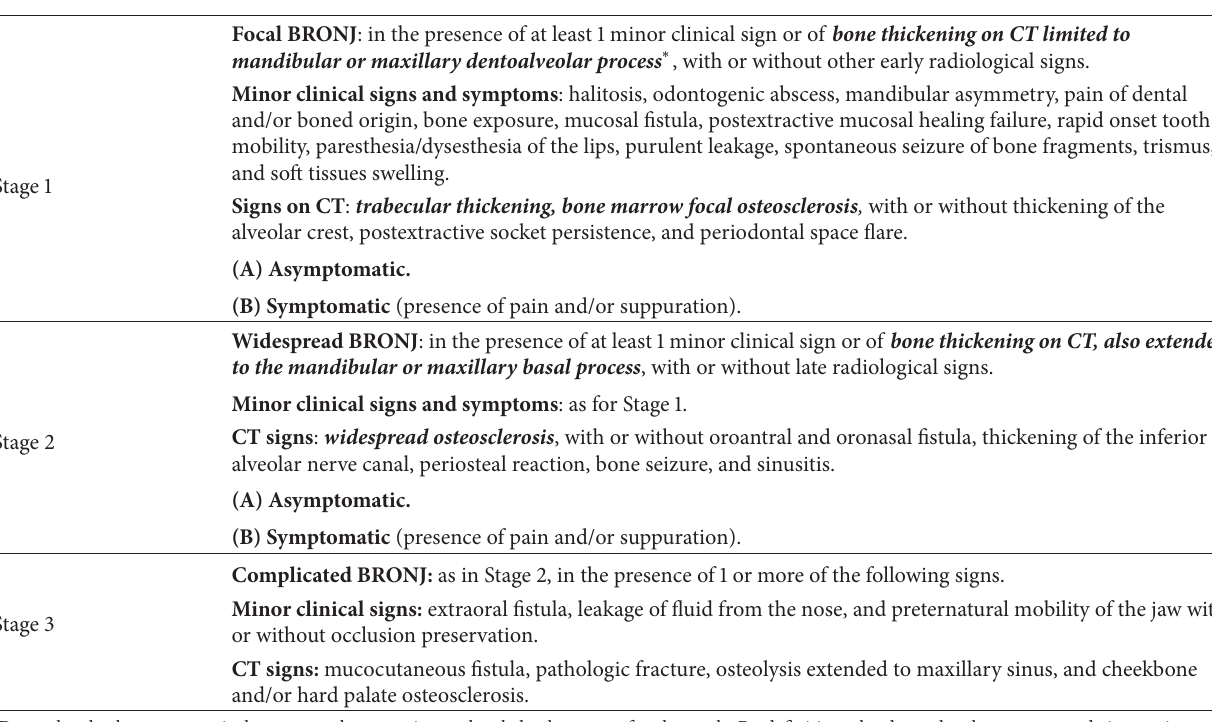
Table 1: 2013 SIPMO/SIMCF clinical-radiological staging of BRONJ